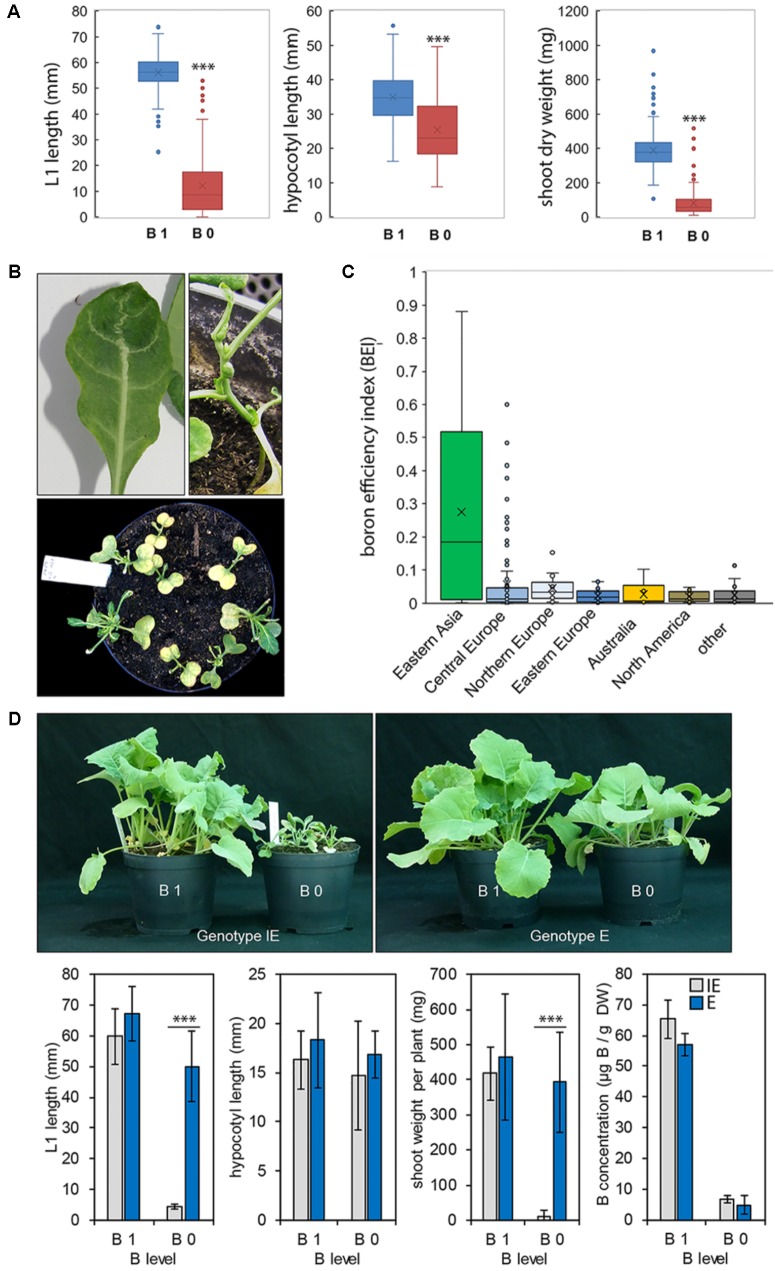
(A) Boxplots showing the distribution of boron (B) efficiency parameters recorded for 234 spring-type Brassica napus accessions. Left panel: length of leaf 1 ( = L1) in millimeters. Middle panel: hypocotyl length in millimeters. Right panel: shoot dry weight (DW) in milligrams. Crosses inside boxes show average values, horizontal lines within boxes mark the median value. Each boxplot consists of 234 parameter average values. Each parameter average value derives from n ≥ 10 plants. Significance between treatments (B 0/B 1) was calculated using t-test: ∗∗∗p < 0.001. (B) Exemplary pictures of plants of B-inefficient B. napus cultivars grown on B-deficient zerosoil-substrate and displaying B deficiency phenotypes such as arrested shoot apical meristem growth and leaf- and vasculature deformations. (C) Origin-dependent distribution of B efficiency indices (BEIs), calculated from the B 0/B 1 ratios of the B-related parameters L1 length and DW. Crosses inside boxes show average values, horizontal lines inside boxes mark the median value. Each boxplot consists of the BEI average values from n ≥ 10 plants. (D) Phenotypes (top panel), growth parameters (lower panel), and B concentrations (lower panel) in leaves of 25-day-old plants of B-inefficient (CR2262 = IE) and B-efficient (CR2267 = E) B. napus cultivars growing on zerosoil-substrate containing sufficient (B 1) or deficient (B 0) B levels. Growth parameters and B concentrations are means ± SD from n = 12 plants. Significance was calculated using t-test: ∗∗∗p < 0.001.